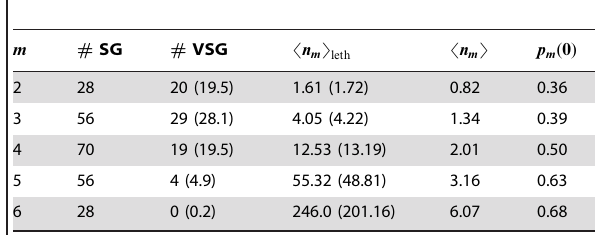
The table summarizes properties of subgraphs of sizes m ~ 2, ::: ,6 of the empirical A. niger fitness landscape. Second column shows the total number of containing any non-viable genotypes, with the model prediction (10) given in brackets. Fourth column contains the number of accessible paths that would